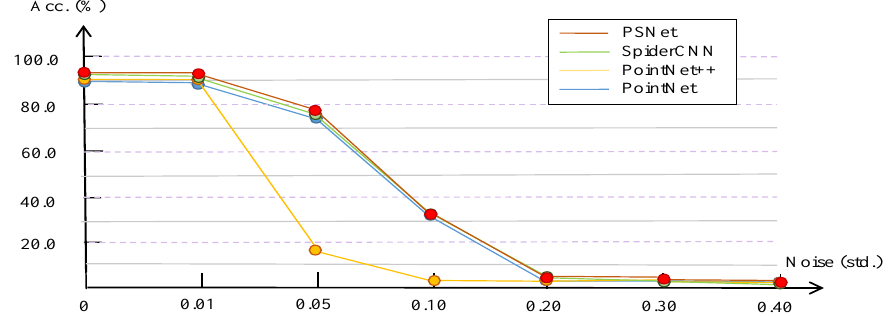
Figure 7. Ablation study for robustness of PSNet with different levels of noise. Our PSNet remains robust with a noise level of 0.01. Compared with SpiderCNN, PointNet++ and PointNet, our PSNet achieves better performances under noise levels of 0.01, 0.05, 0.10 and